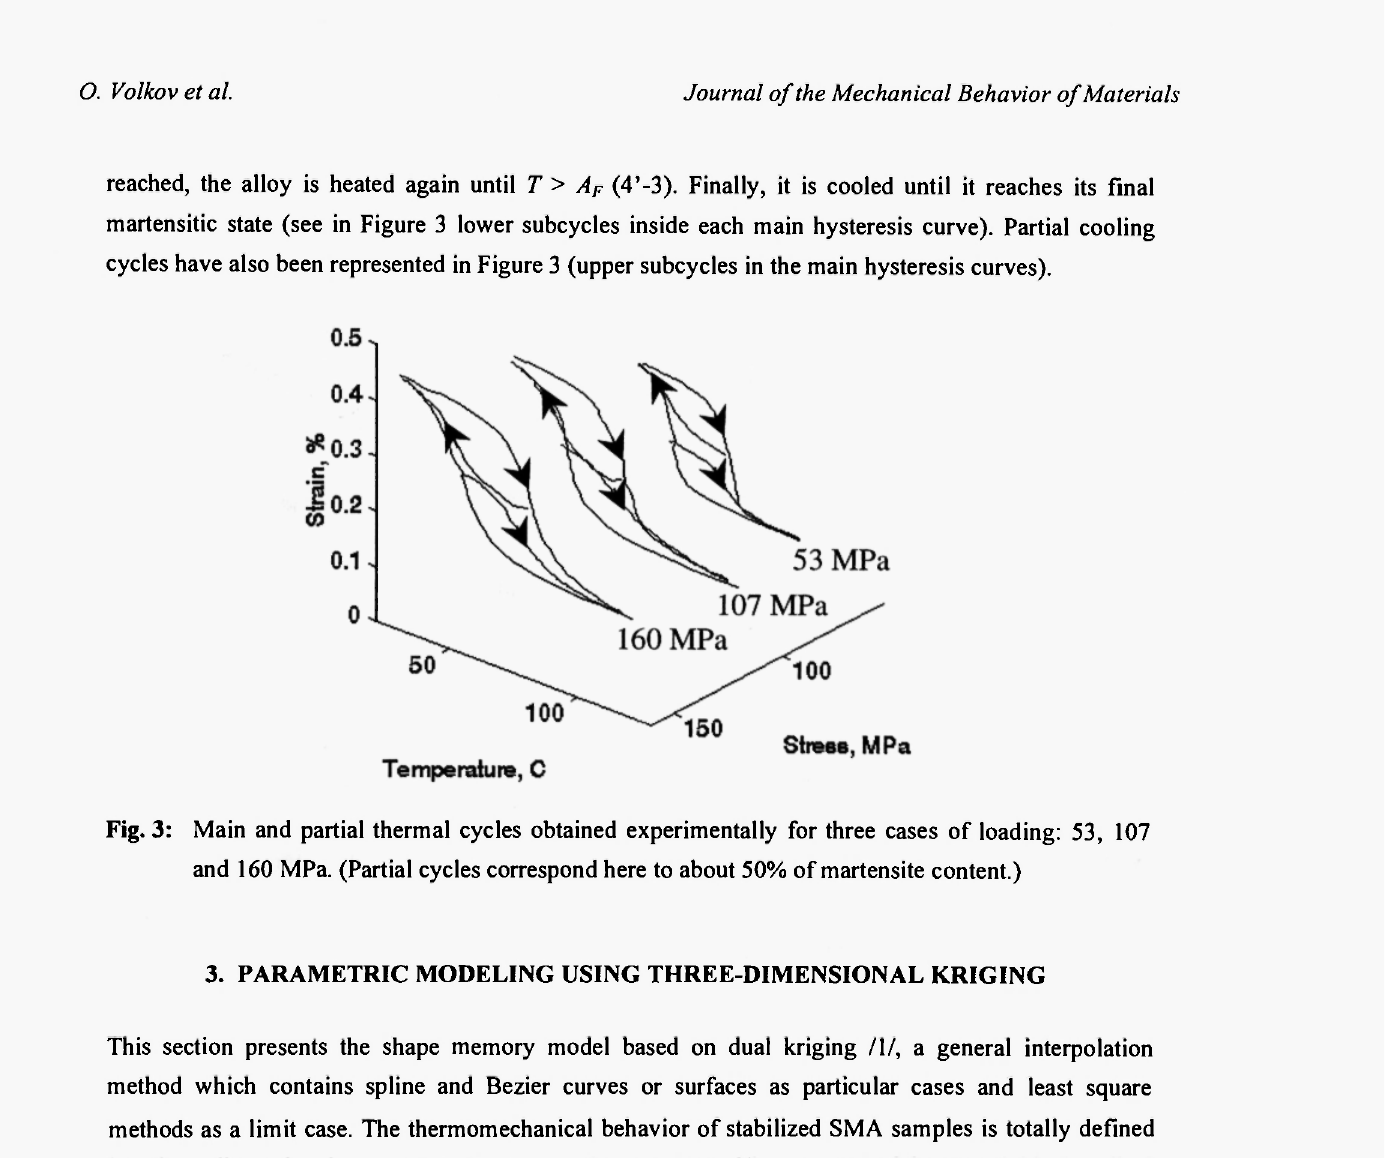
Fig. 3: Main and partial thermal cycles obtained experimentally for three cases of loading: 53, 107 and 160 MPa. (Partial cycles correspond here to about 50% of martensite